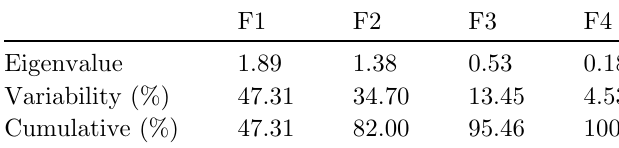
Table 9. Eigenvalues of the presentative axes of the PCA.